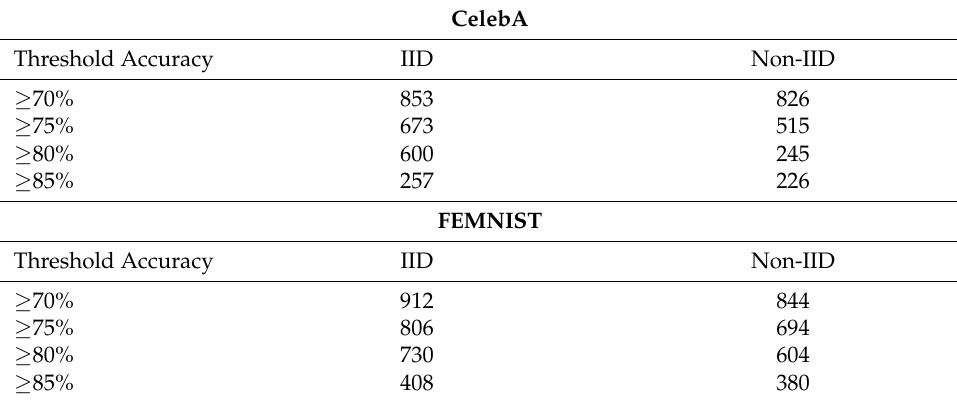
Table 6. The number of selected representatives with respect to four different threshold values on the LEAF datasets CelebA (top) and FEMNIST (bottom) for 100 global rounds.